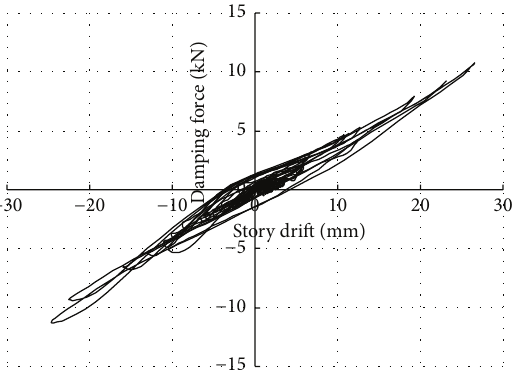
Figure 12: Hysteretic loop of interaction force of the test structure at the 1st floor with predictive control of 0.10 seconds under excitation of the Kobe earthquake with PGA = 0.946 m/sec 2 (94.6